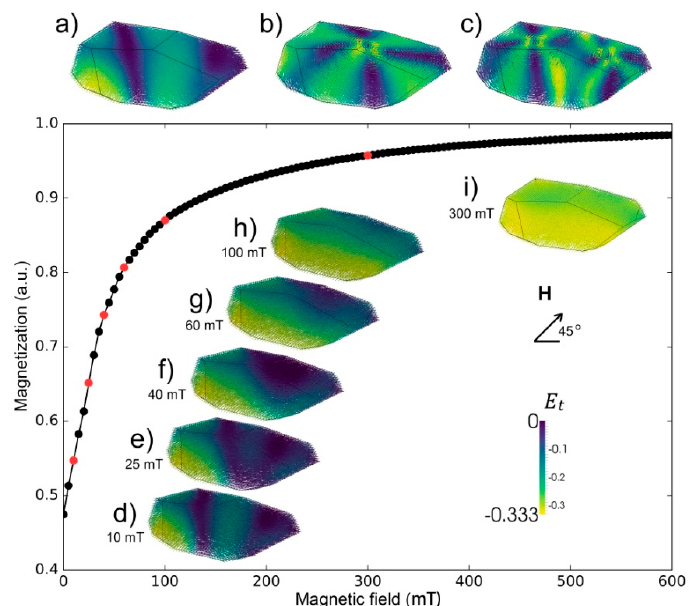
Figure 1. Micromagnetic model of the magnetization and magnetic structure of a magnetite particle in zero field and a field. ‘Ek’ is the magnetocrystalline anisotropy energy. ( a – c ) three zero-field structures determined from different initial random starting states: ( a ) ‘two-domain’ state, ( b ) single-vortex state, and ( c ) double-vortex state. ( d – i ) magnetic structures along the applied-field magnetization curve for the ‘two-domain’ state. The red dots correspond to the images ( d – f ) etc. The magnetic structures are colored by the local magnetocrystalline anisotropy field energy; dark blue areas are ‘domain walls’, and yellow areas ‘domains’. The magnetization is normalized by the particles’ saturation magnetization.